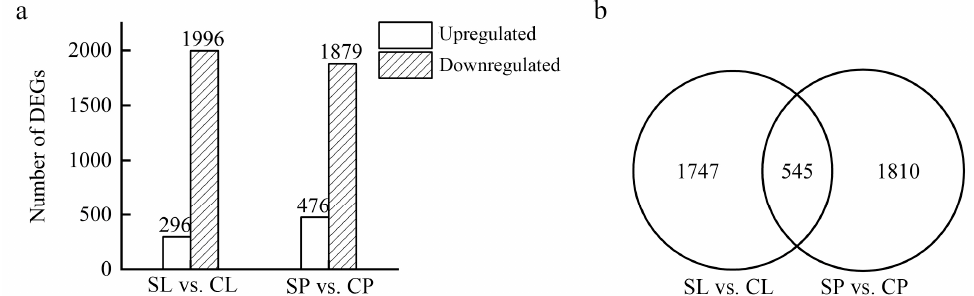
Figure 5. Differentially expressed genes between young floating leaves and petioles under salt treatment. Floating leaves and petioles were collected from water lilies treated with 0 and 150 mM NaCl for 21 days and used for RNAseq: floating leaves treated with 150 mM NaCl (SL), floating leaves treated with 0 mM NaCl (CL), petioles treated with 150 mM NaCl (SP), and petioles treated with 0 mM NaCl (CP). ( a ) Number of DEGs in young floating leaves and petioles under salt treatment. ( b ) Venn diagram of DEGs in young floating leaves and petioles under salt treatment.